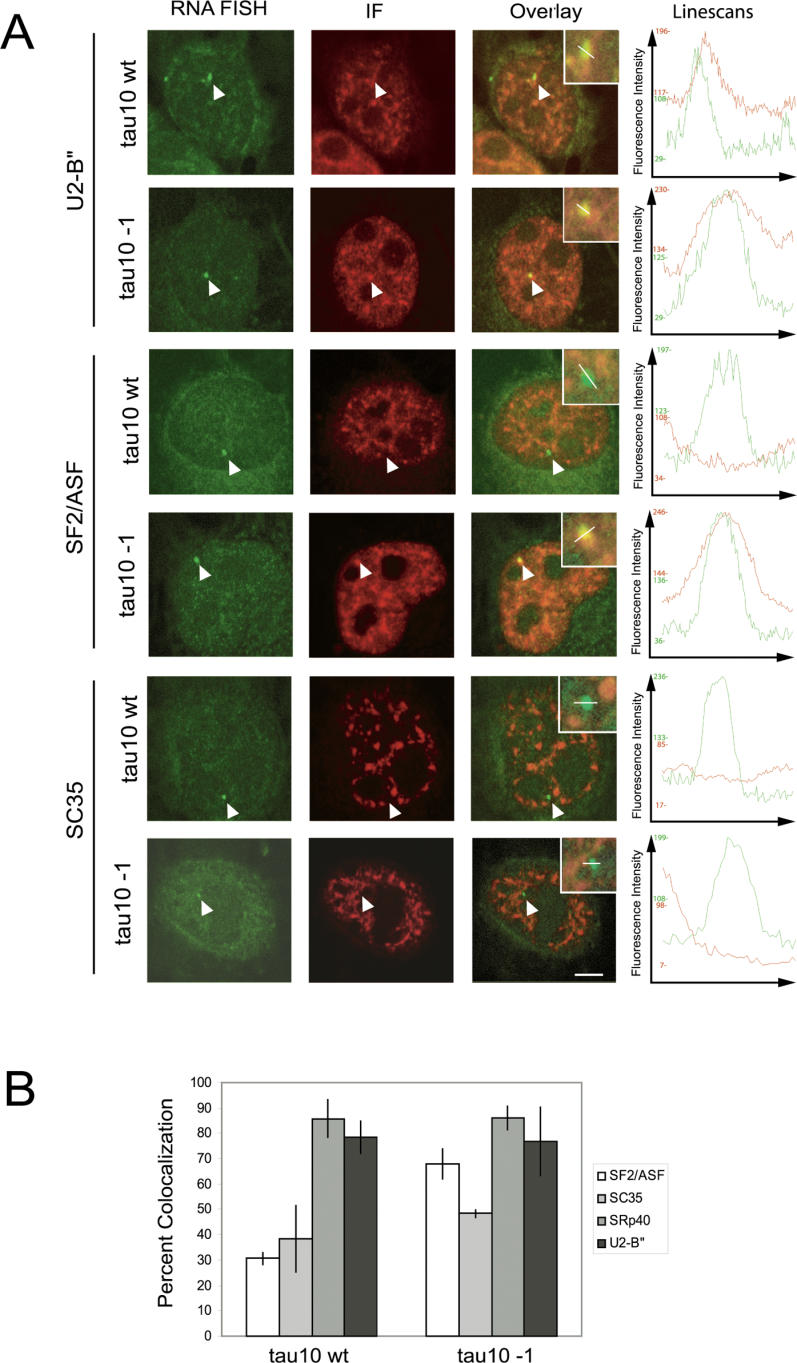
Differential Recruitment of Endogenous Pre-RNA Splicing Factors to Alternatively Spliced Transcripts(A) Recruitment of splicing factors to tau transcription sites detected by combined RNA-FISH using specific probes against the tau minigene (green) and IF microscopy with specific anti-splicing factor antibodies (red). Arrowheads indicate tau transcription sites. All associations were confirmed by linescan analysis. Scale bar = 2.5 μm. (Inset: higher magnifications of the transcription site) Lines indicate the location of the linescans.(B) Quantitation of percentage of cells with colocalization of tau RNA-FISH and splicing factor signals. Values represent averages from at least 100 transcription sites from at least three experiments ± SEM.